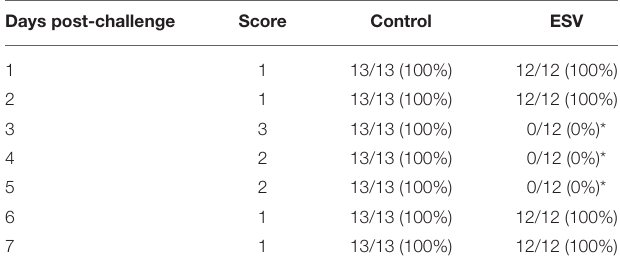
Experiment 2. Data are expressed as the number of piglets with diarrhea score/number of piglets in the group (%). Diarrhea scores: 1, well-formed feces; 2, mild diarrhea; 3, severe diarrhea. * Asterisk within rows indicates a significant difference at P < 0.001.